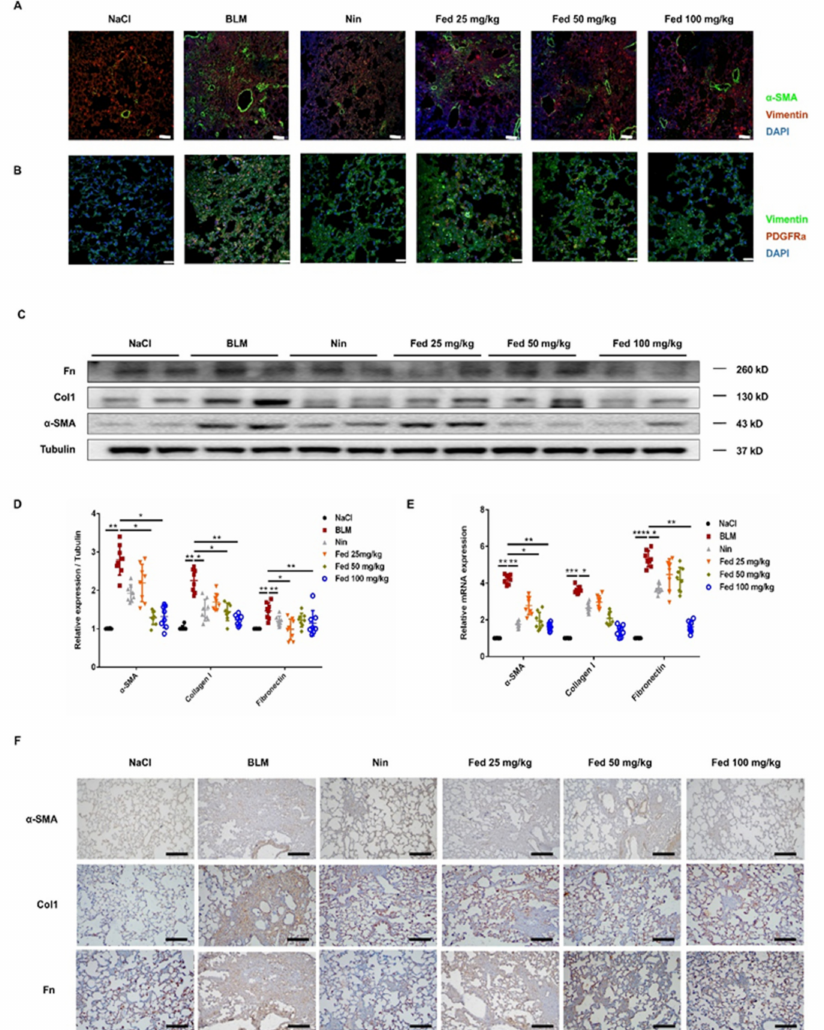
Figure 8. Fedratinib alleviates myofibroblast activation in bleomycin-induced mice through inhibiting both JAK2/STAT3 and TGF- β 1 signaling. ( A ) Immunofluorescence staining of α -SMA and